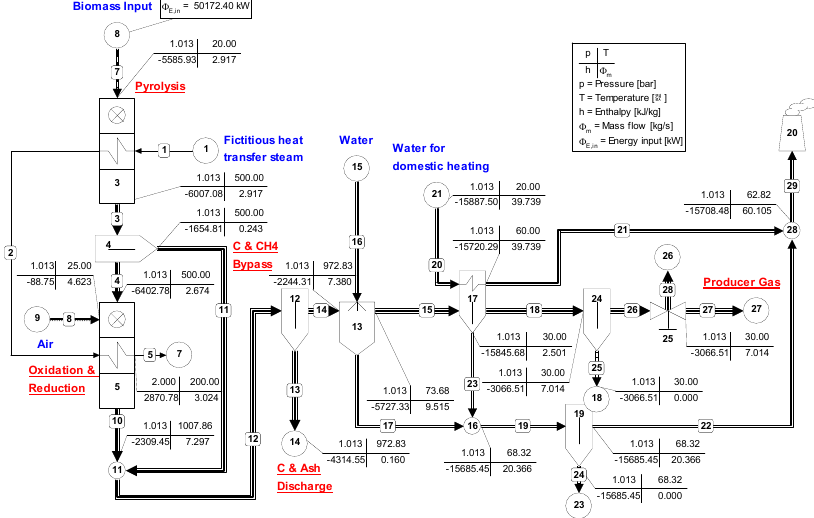
Figure 2. Two ‐ reactor model of biomass downdraft gasifier. Figure 2. Two-reactor model of biomass downdraft